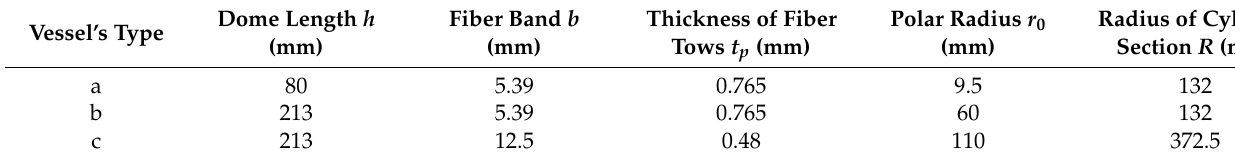
Table 1. The parameters of three composite vessels.